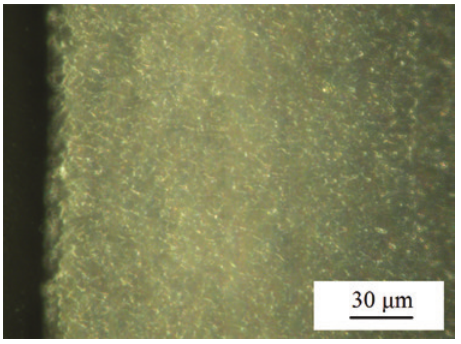
Figure 1: Optical micrograph of 2.5 wt.% MWCNT/PC composite obtained at the injection temperature of 280 ° C and injection speed of 10